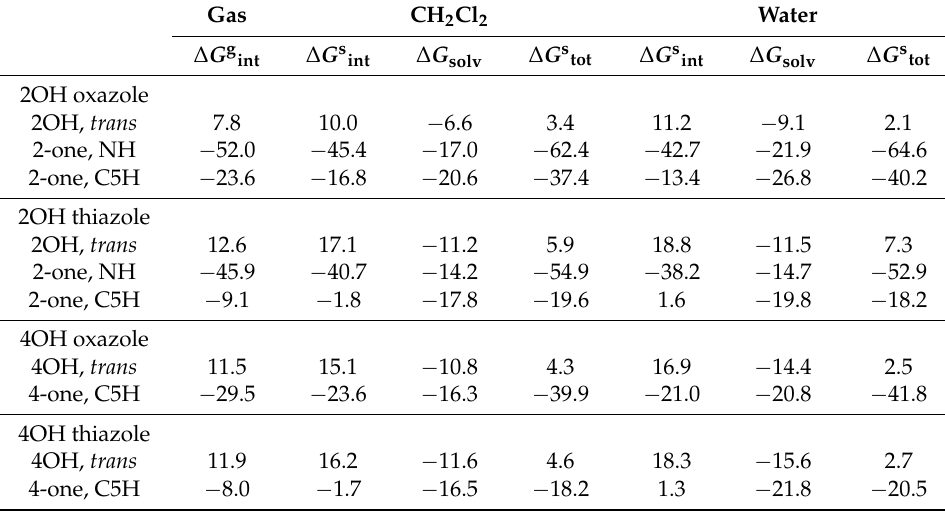
Table 1. Relative free energies for the conformers/tautomers of the oxazole and thiazole OH derivatives. Energy terms in kJ/mol relative to the corresponding cis OH species a . Gas CH 2 Cl 2 Water ∆ G g ∆ G s ∆ G int int solv